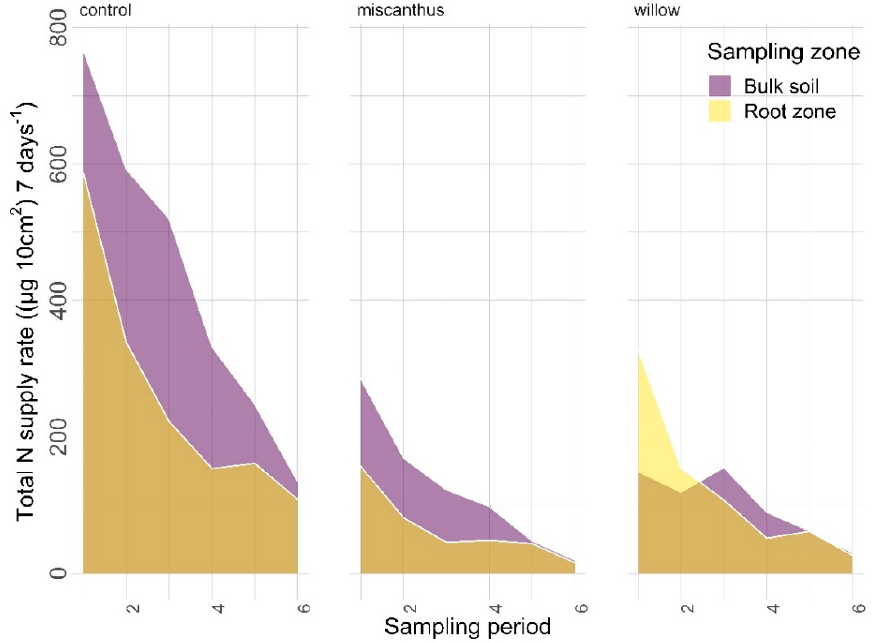
Figure 4. Total N supply rates measured in the bulk soil and the root zone as a function of time and amendment.